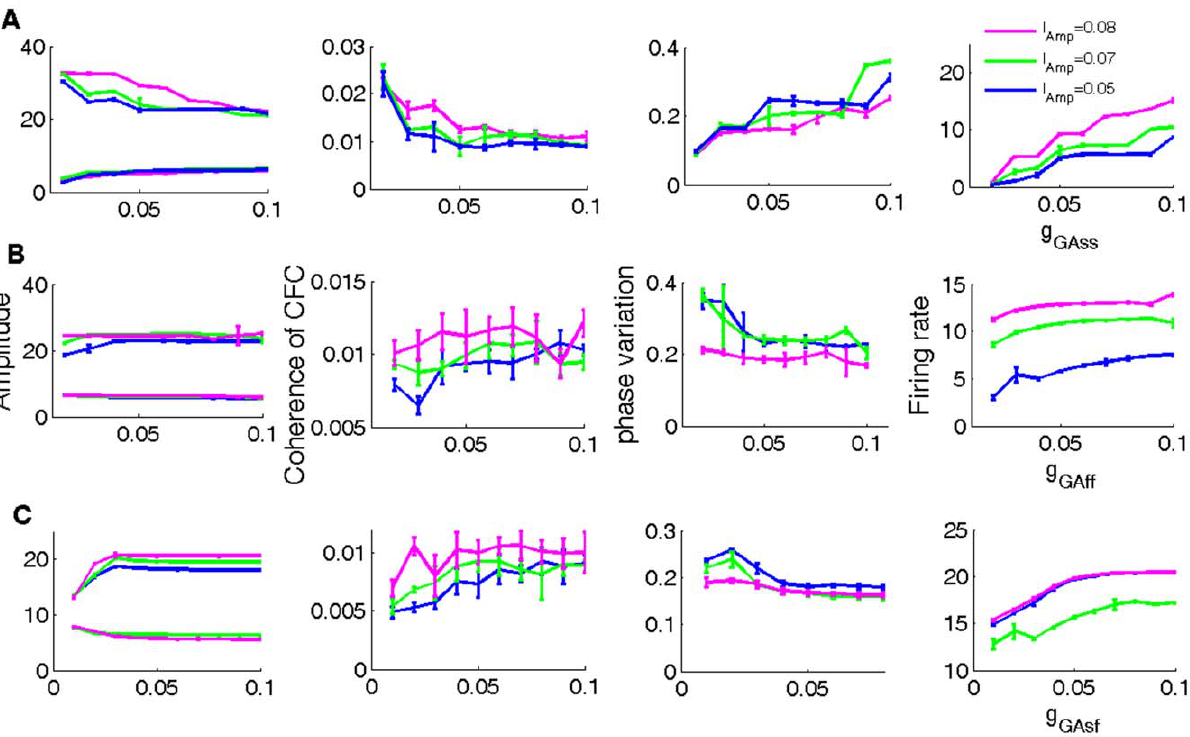
Figure 3. Effects of modulating GABA conductances between and within inhibitory cells. The amplitudes of theta and gamma oscillations, the coherence of CFC, theta phase variation and the firing of excitatory neurons as a function of changes in the strength of (A) g GAss ’ (B ) g Gff (C) g GAsf are shown.